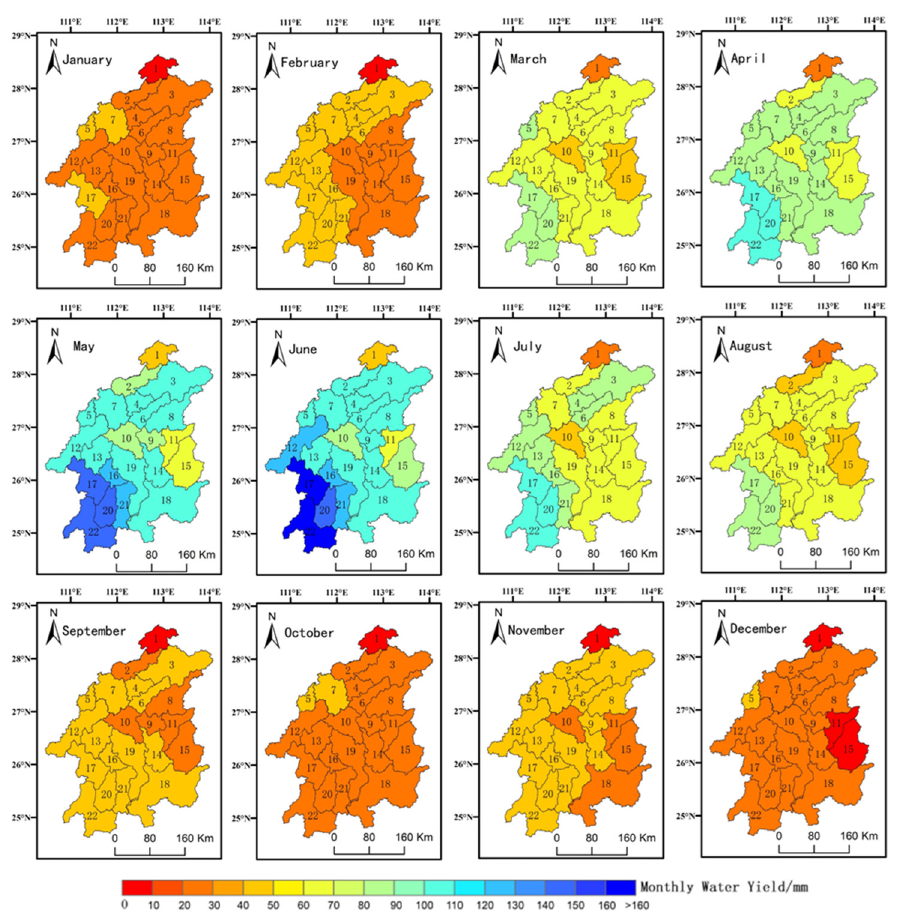
Figure 5. Spatial variation in monthly average water yield.